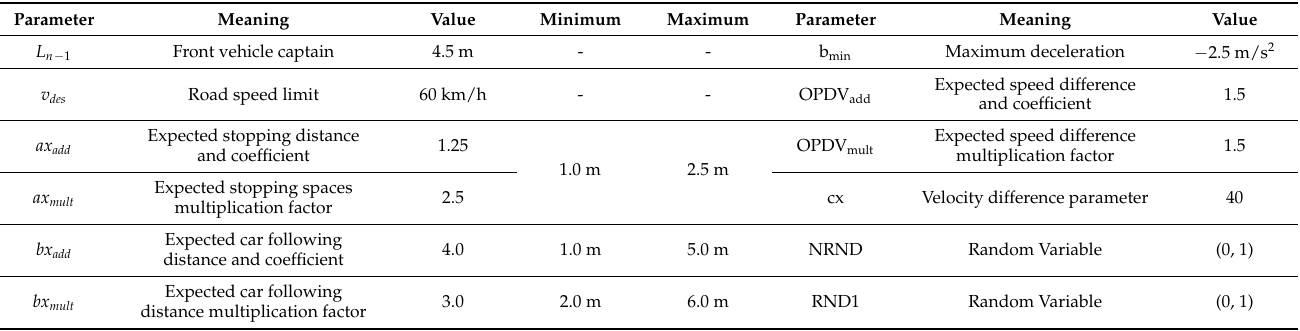
Table 2. Widemann74 car-following model